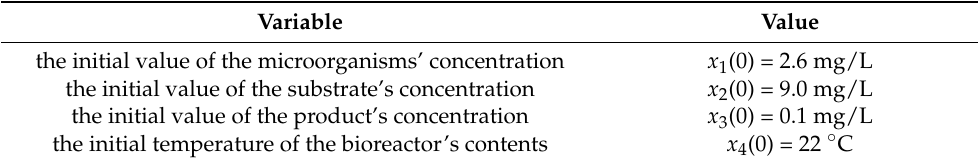
Table 1. Initial values of the fermentation process in the studied bioreactor.